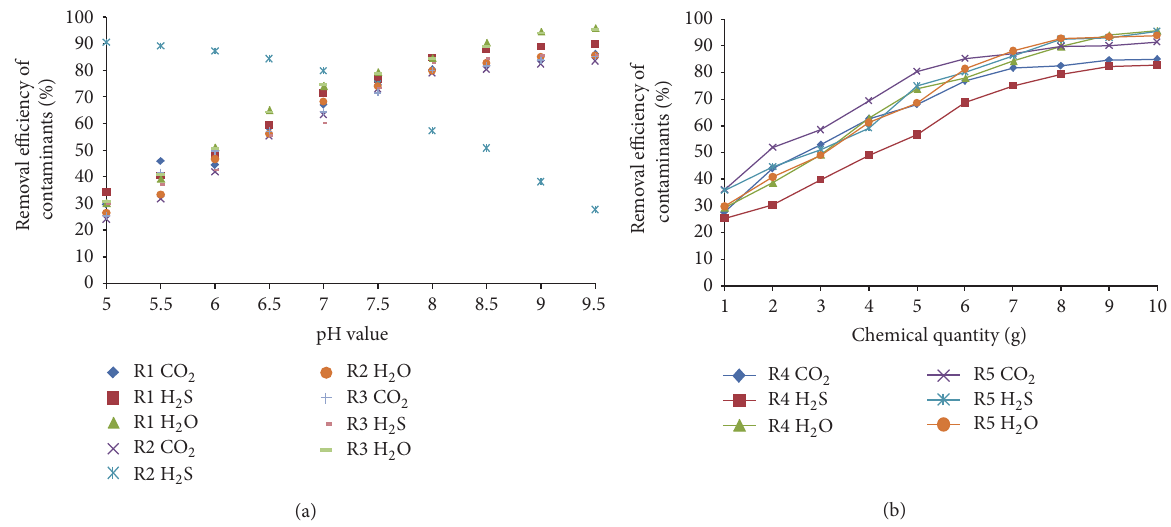
Figure 5: (a) CO 2 , H 2 S, and H 2 O removal efficiency of biogas under the treatments of runs R1, R2, and R3 and (b) for runs R4 and R5.